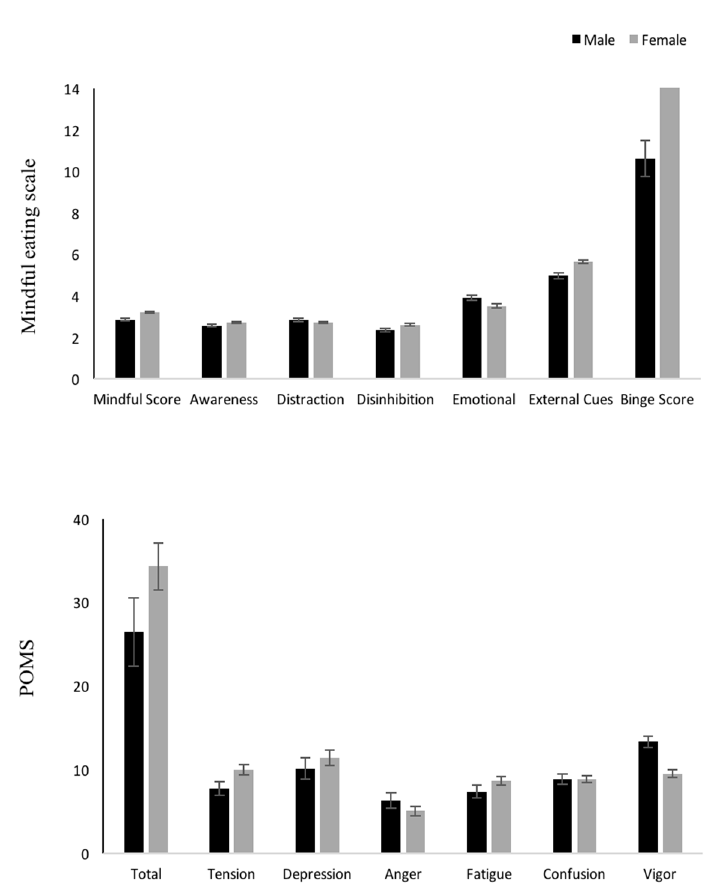
Figure 3. Di ff erences between genders in mindful eating total scores and subscales, binge eating total scores, and POMs total scores and subscales (Mean ± SEM) * p <